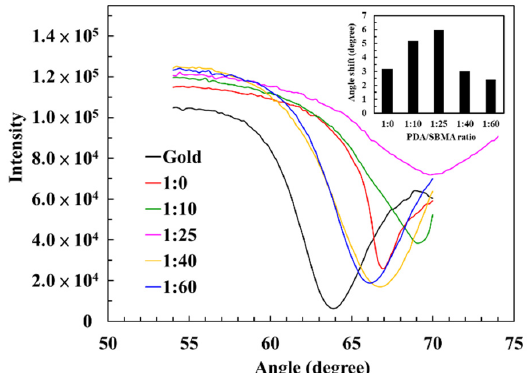
Figure 3. Surface plasmon resonance (SPR) curve of the various PDA / SBMA coatings. The inset shows